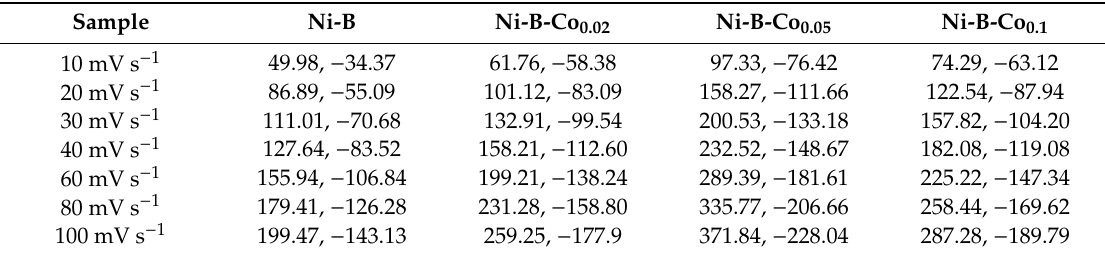
Table 1. The NiOOH / Ni(OH) 2 oxidation (left) and reduction (right) peak currents (A g − 1 ) on Ni-B and Ni-B-Co